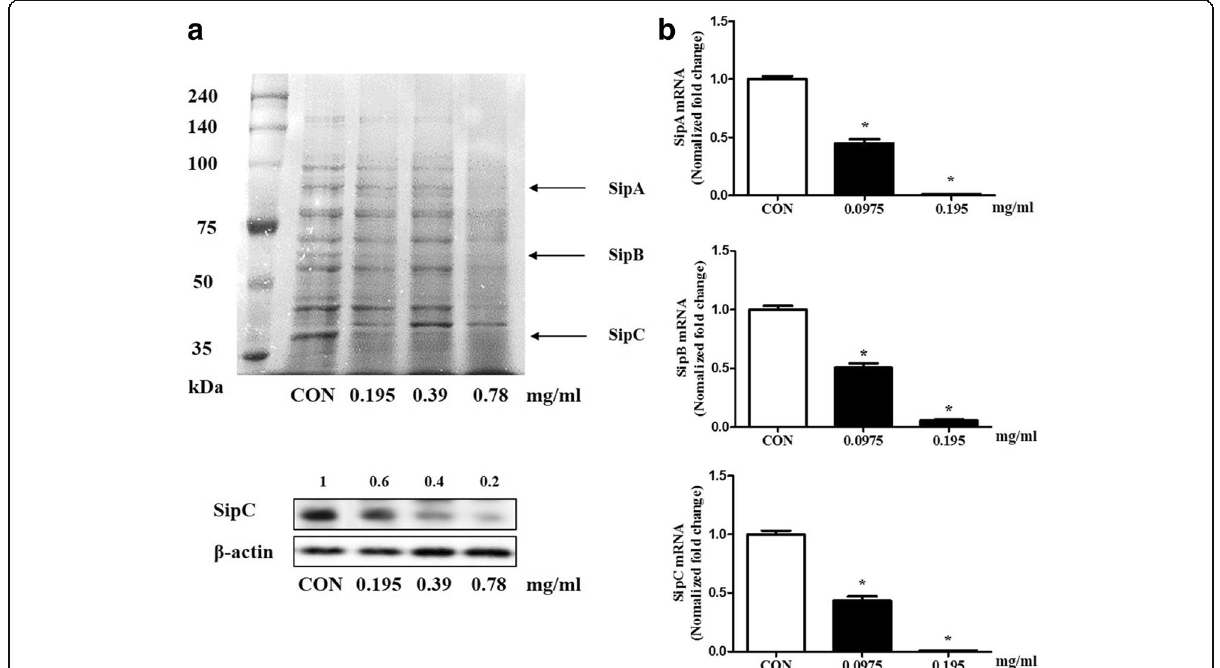
Fig. 3 Colla corii asini ethanol extract inhibited the proteins and mRNAs of T3SS-1 effectors in S. typhimurium. We detected the secretion of T3SS-1 effectors in the bacterial supernatant by western blotting. a The Colla corii asini ethanol extract (0.195 mg/ml) significantly reduced the salmonella invasion proteins such as SipA, SipB and SipC. b We treated S. typhimurium with various concentrations of Colla corii asini ethanol extract. After 24 h, we extracted mRNA from S. typhimurium and conducted real-time PCR. Colla corii asini ethanol extract (0.195 mg/ml) significantly decreased